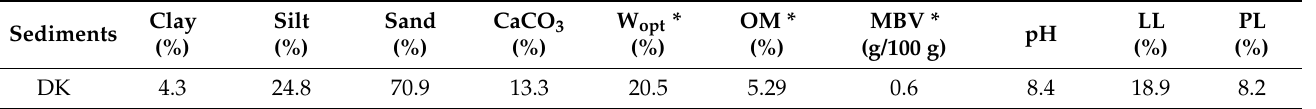
Table 1. Dunkirk sediments